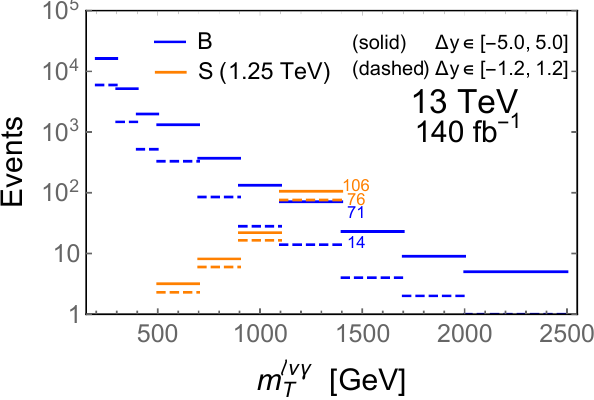
Figure 5 . Transverse cluster mass distribution for W + ( ‘ + (cid:23) ) (cid:13) production; background (blue) and a benchmark signal (orange) using the triplet scalar model introduced in eq. (3.1). Solid lines include all events in the m ‘(cid:23)(cid:13) bins, whereas dashed lines only include events for which (cid:1) y 2 [ (cid:0) 1 : 2 ; 1 : 2]. T The small orange and blue numbers represent the number of events in the 1.25 TeV bin for signal (orange) and background (blue) without (solid) and with (dashed) the (cid:1) y